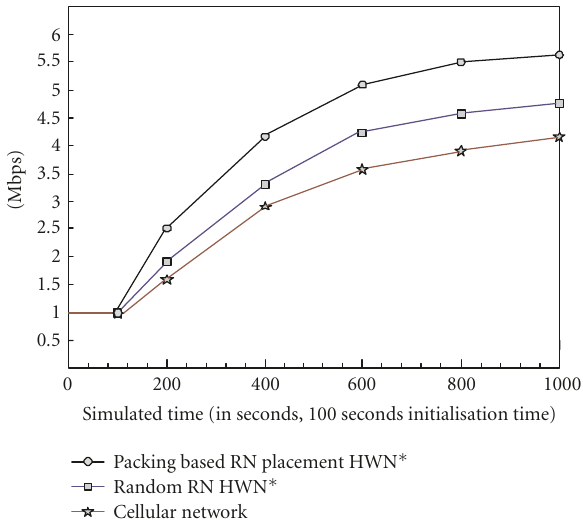
Figure 7: Average capacity comparison of packing RN HWN ∗ , random RN HWN ∗ , and cellular network.